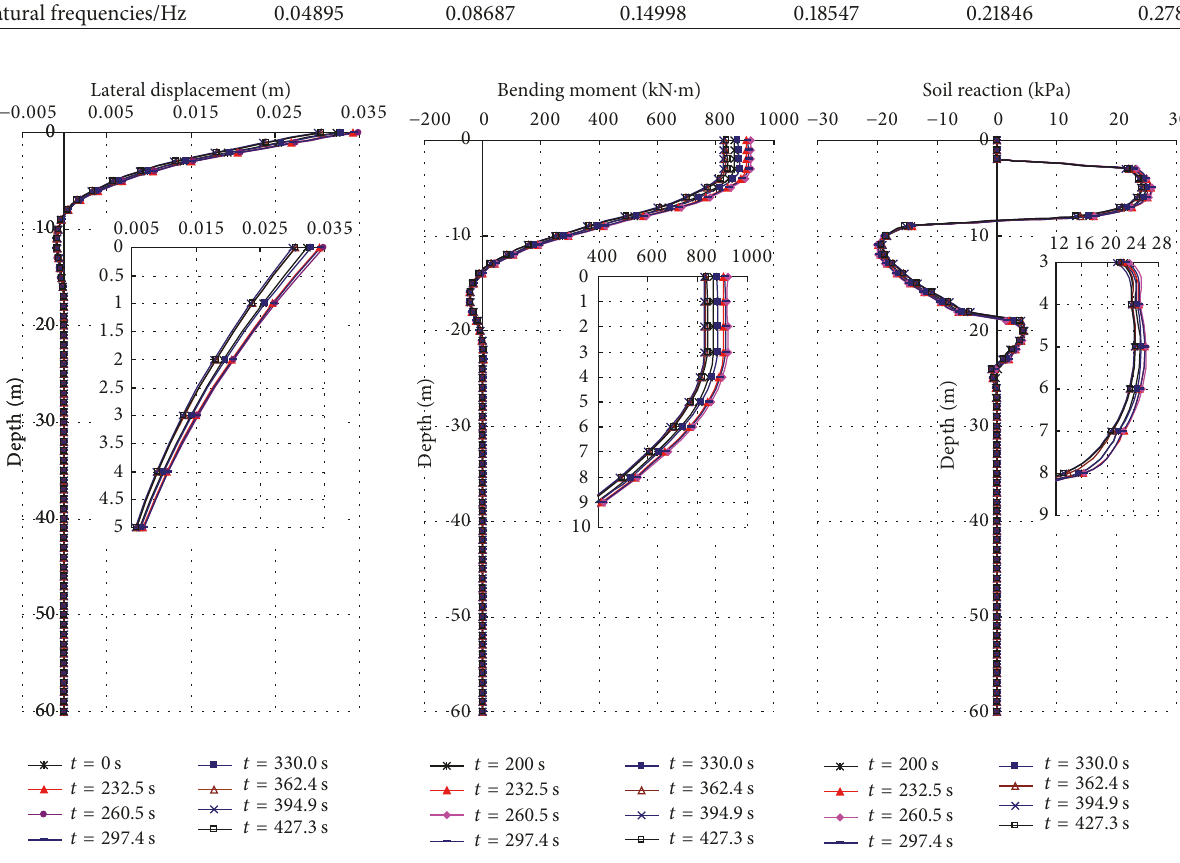
Figure 10: Deformation and stresses of the conductor in a drift